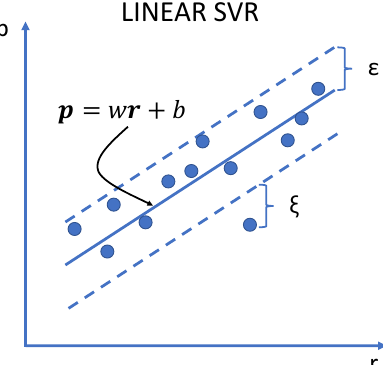
Figure 3. Support–vector regressor (SVR) example for a two-dimensional problem, using a linear